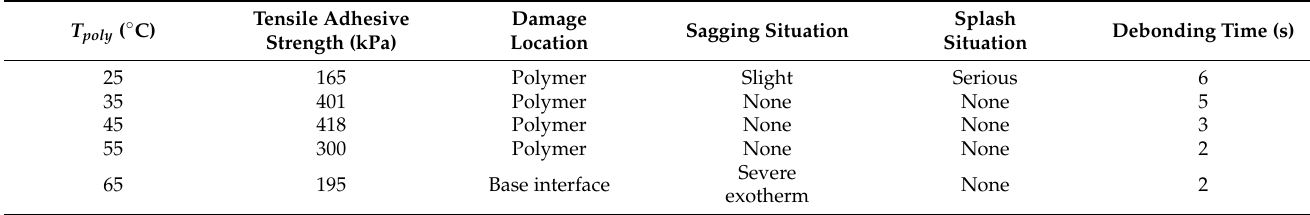
Table 2. Effects of initial material temperatures on spraying performance.